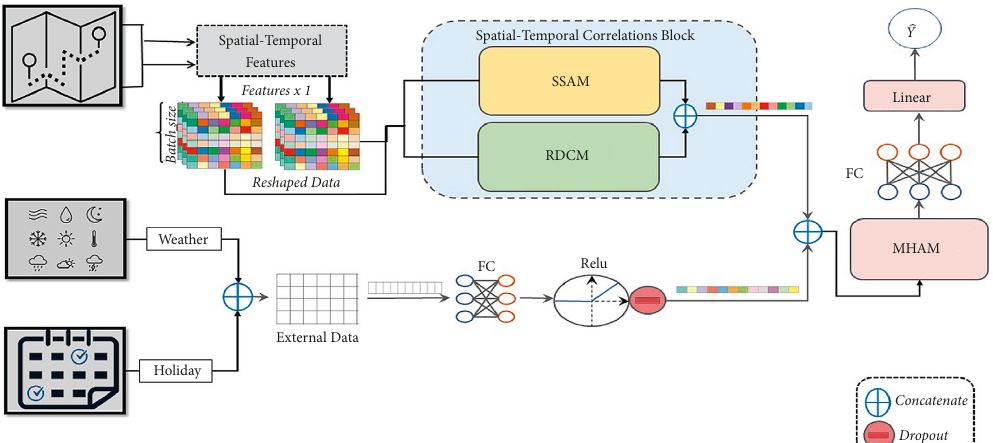
Figure 4: Joint spatial and temporal correlation (JSTC) mechanism architecture combines spatiotemporal correlation block, which includes the spatial self-attention module (SSAM) and residual dilated convolutional module (RDCM). Then, we used a multi-head attention module (MHAM).